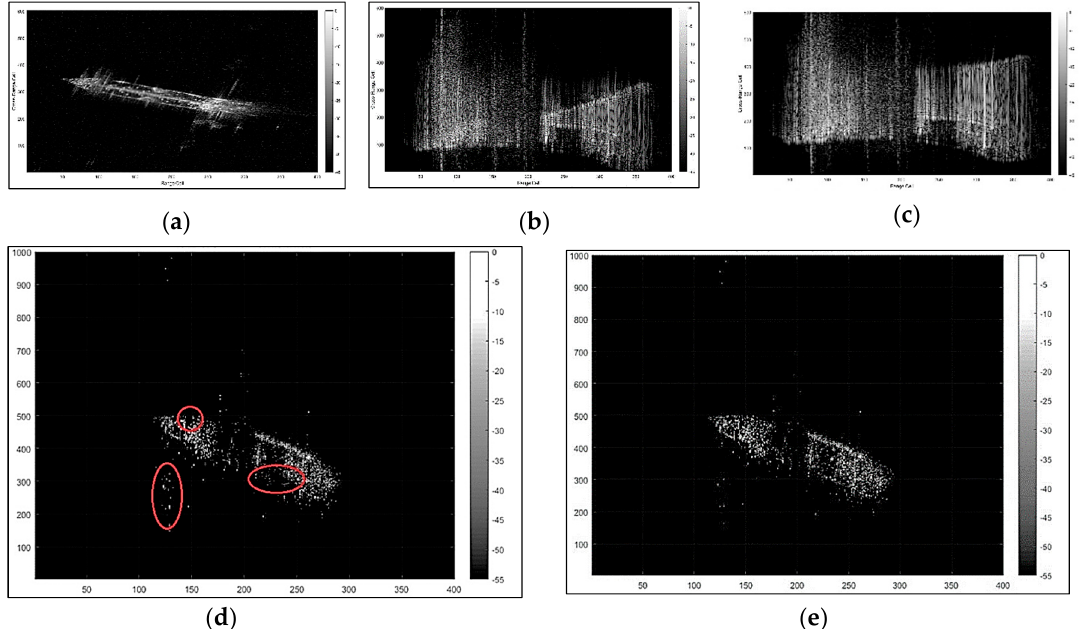
Figure 4. Imaging results of the GF-3 data: ( a ) imaging result of stationary vessel; ( b ) imaging result of moving vessel; ( c ) imaging result of the inverse synthetic aperture radar (ISAR) process; ( d ) imaging result of classical PSO; ( e ) imaging result of co-evolutionary PSO.